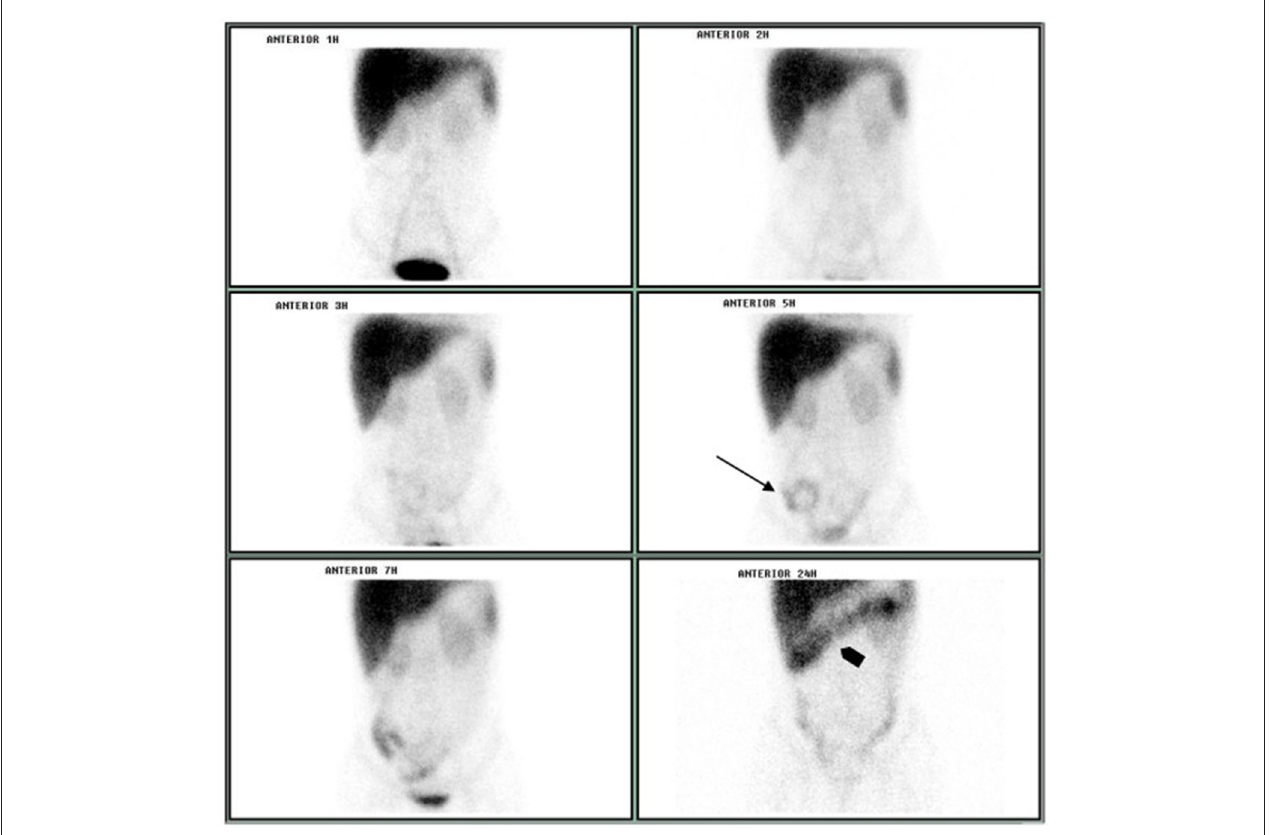
FIGURE 1 | Sequential abdominal scintigraphy performed after the IV injection of 99m Tc-albumin: protein loss was unequivocally visualized on small bowel projection at 5h image (arrow) with progression to colon at 24h image (arrowhead).